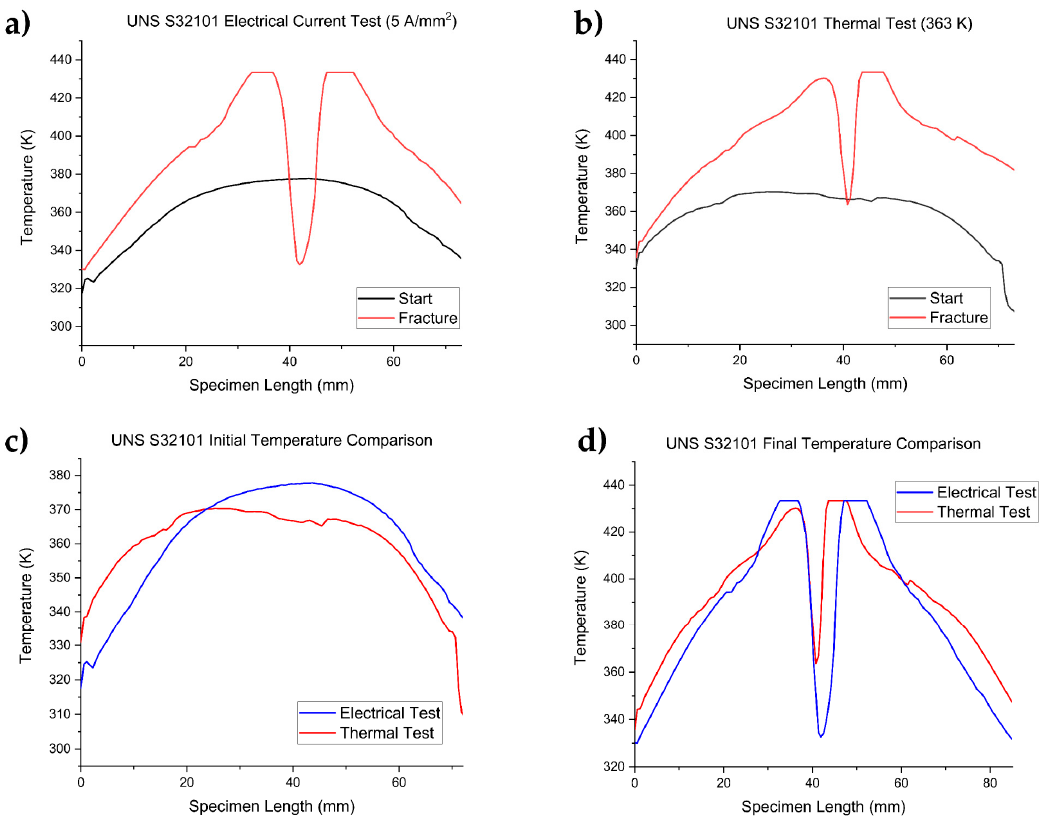
Figure 5. Evolution of temperature along the specimen length of UNS S32101: ( a ) tensile test at 5 A / mm 2 ; ( b ) tensile test at 363 K; ( c ) comparison between temperature regimes of specimen tested at 5 A / mm 2 and the corresponding thermal test at 363 K at the beginning of the tensile test; and ( d ) comparison between temperature regimes of specimen tested at 5 A / mm 2 and the corresponding thermal test at 363 K right after fracture occurred.